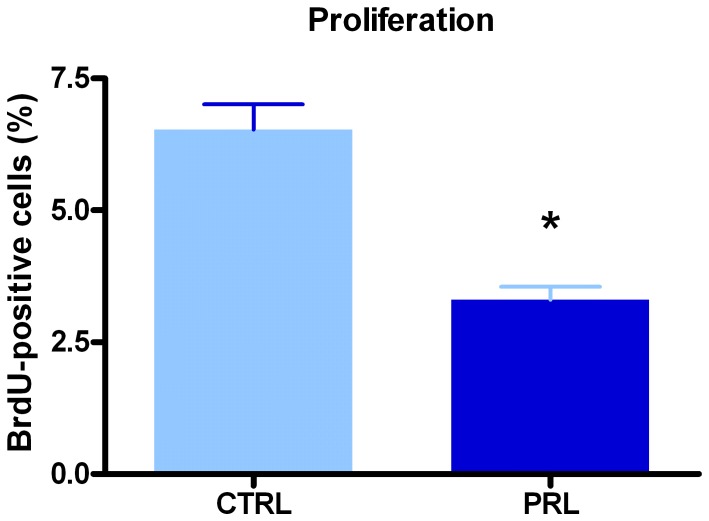
PRL decreases anterior pituitary cell proliferation in vivo.Ovariectomized rats (n = 4 rats/group) were injected with oPRL (1 mg/kg, 6 h) or saline and BrdU (50 mg/kg, 6 h). Proliferation rate was determined by the detection of BrdU incorporation and FACS analysis. Each column represents the mean ± SEM of the percentage of BrdU-positive cells. *p<0.05 vs. respective control (CTRL) animals injected with vehicle, Student's t test.